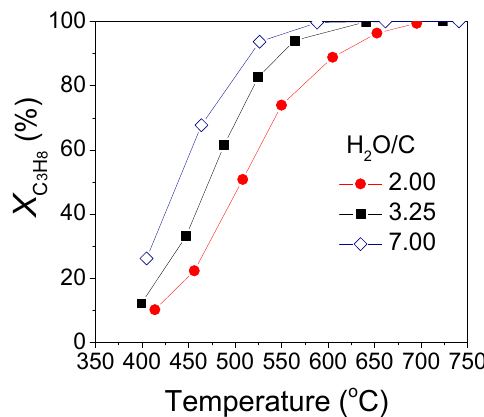
Figure 2. Effect of H 2 O/C ratio on the conversion of C 3 H 8 obtained as function of reaction temperature over 0.5%Rh/TiO 2 catalyst. Experimental conditions: Gas Hourly Space Velocity (GHSV): 55,900 h − 1 ; particle diameter: 0.15 < d p < 0.25 mm; Feed composition: 2.1–6.1% C 3 H 8 , 0.15–0.20% Ar, 37–44% H 2 O (balance He).